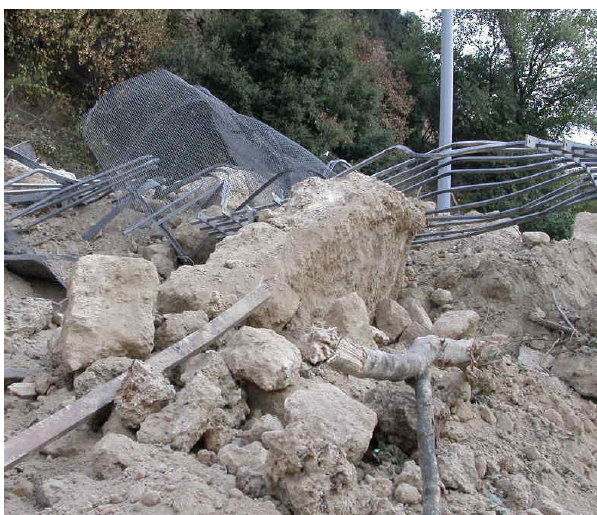
Fig. 3. The western slope of Monti Parioli hill (aerial photograph from Google Maps) and its position inside Roma city area. Let- ters show the position of previous landslide events (A, B, C) and of study event (D); parallel yellow lines show the portion of the slope remodelled into tiers after 1972 event; small yellow squares indi- cate the entrance of the upper cavity system; red triangles indicate rock blocks found at the foot of the slope; red circles (numbered in yellow with 1, 2 and 3) indicate the accesses to the lower cavity system (WWII air-raid